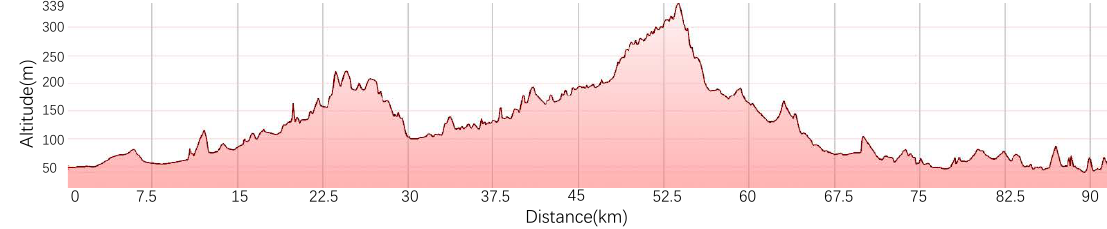
Figure 3. The terrain of the